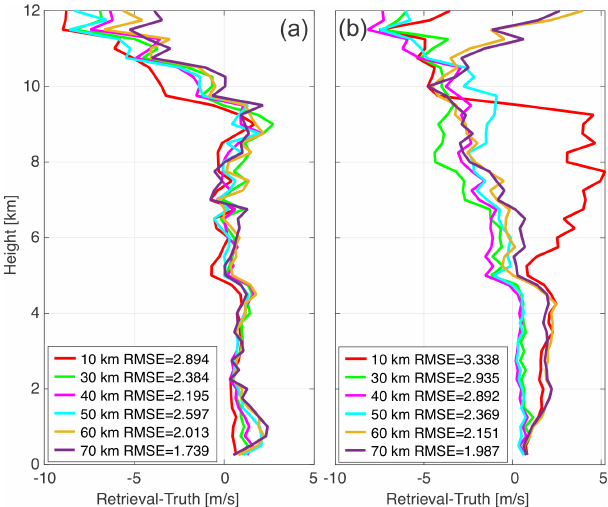
Figure 10. Vertical profiles of errors of simulated retrievals (retrieval–model) averaged over a region with reflectivity > 30dBZ at 21:42UTC for the identified convective cell using the three radars, with two fixed at a distance of 20km (blue dots in Fig. 9a) while one is moved (dots with the other colors in Fig. 9a). In (a) the 2min SEC radar (at the northwest corner of the triangle in Fig. 9a) is moved, and in (b) the 5min VCP radar (at the south corner of the triangle in Fig. 9a) is moved. The colors of lines correspond to the dot’s colors for the moved